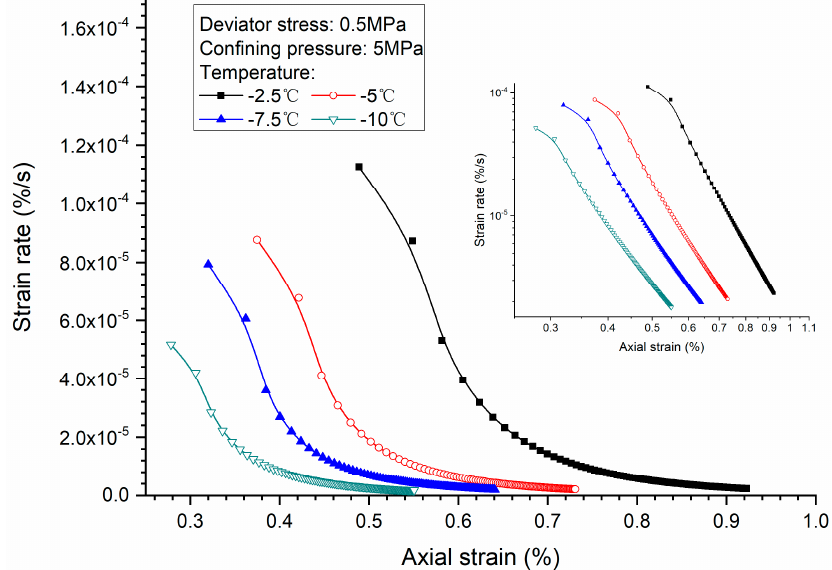
Figure 13. Creep strain rate versus axial strain for methane hydrate-bearing frozen specimens under various temperatures.